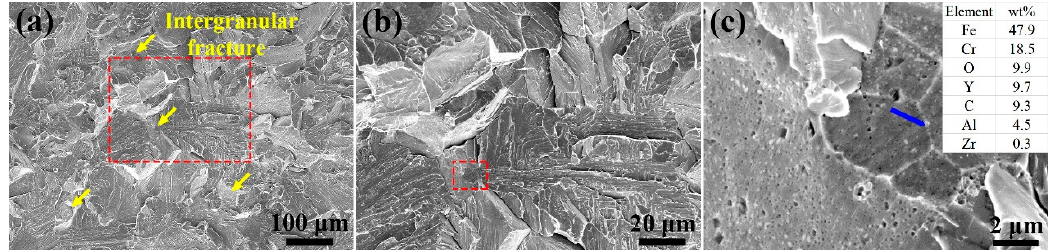
Figure 7. SEM secondary electron micrographs of the fractography for the tensile tested sample: ( a ) macro-morphology; ( b , c ) micrographs of the crack source surface of the as-HIPed alloy A at a high magnification. Figure 8. SEM secondary electron micrographs of the fractography for the tensile tested sample: ( a ) macro-morphology; ( b , c ) micrographs of the crack source surface of the as-HIPed alloy B at a high magnification.